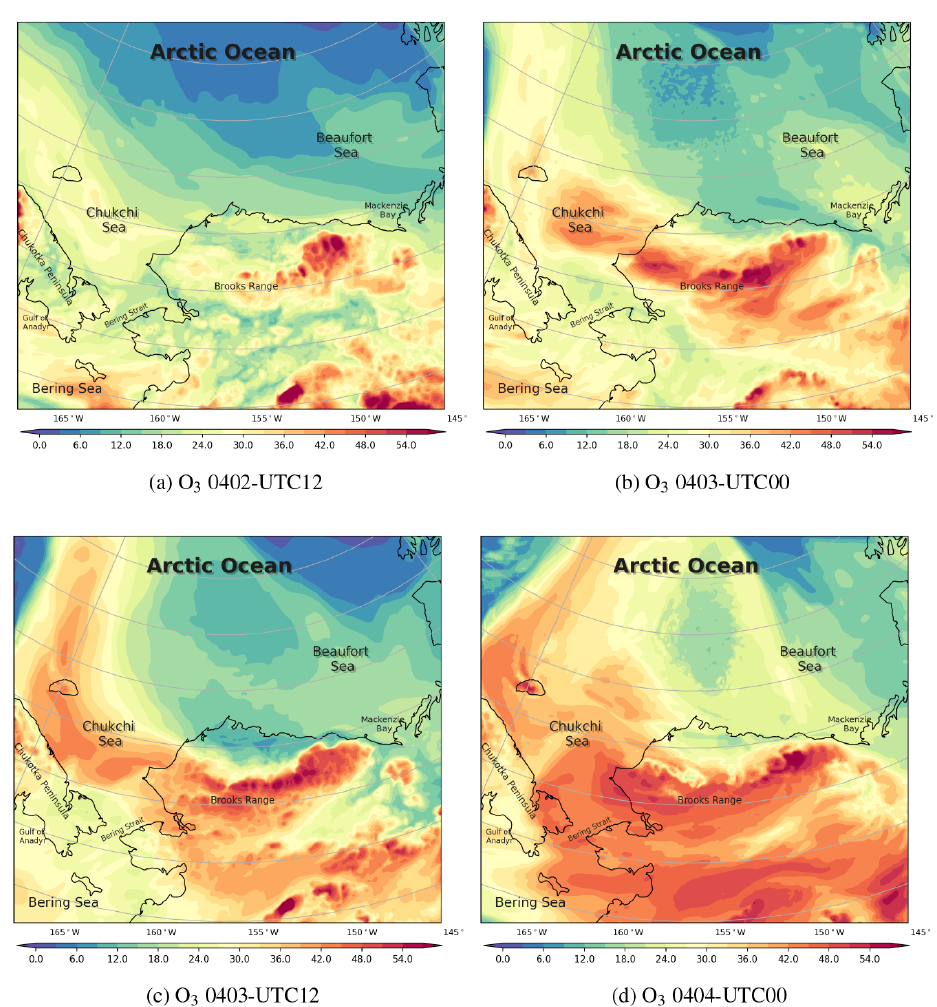
Figure 10. The spatial distribution of the surface ozone (ppb) simulated by CMAQ from 2 to 4 April 2019.